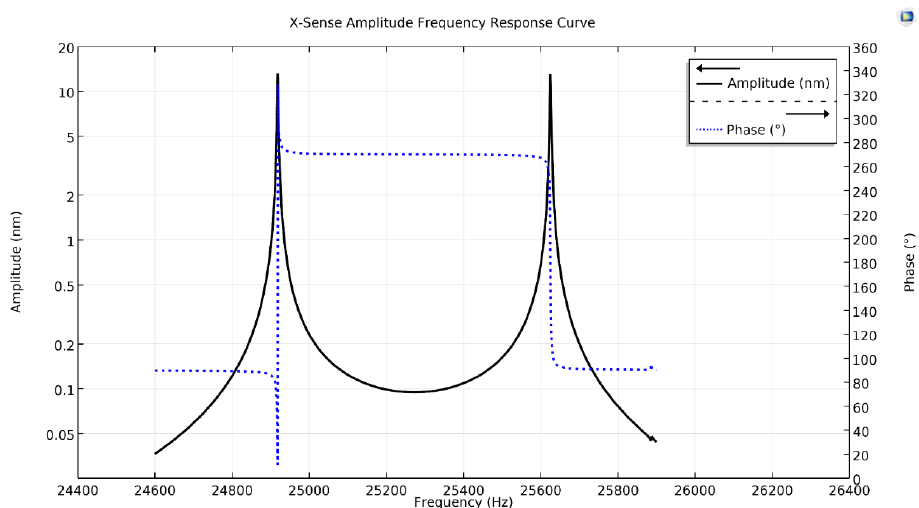
Figure 5. X-sense amplitude frequency response curve of the proposed single-drive, 3-axis MEMS gyroscope.